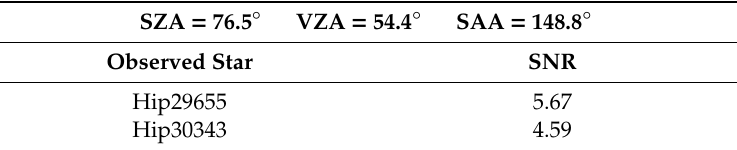
Table 4. Observation conditions and observation results at 8:00 am.